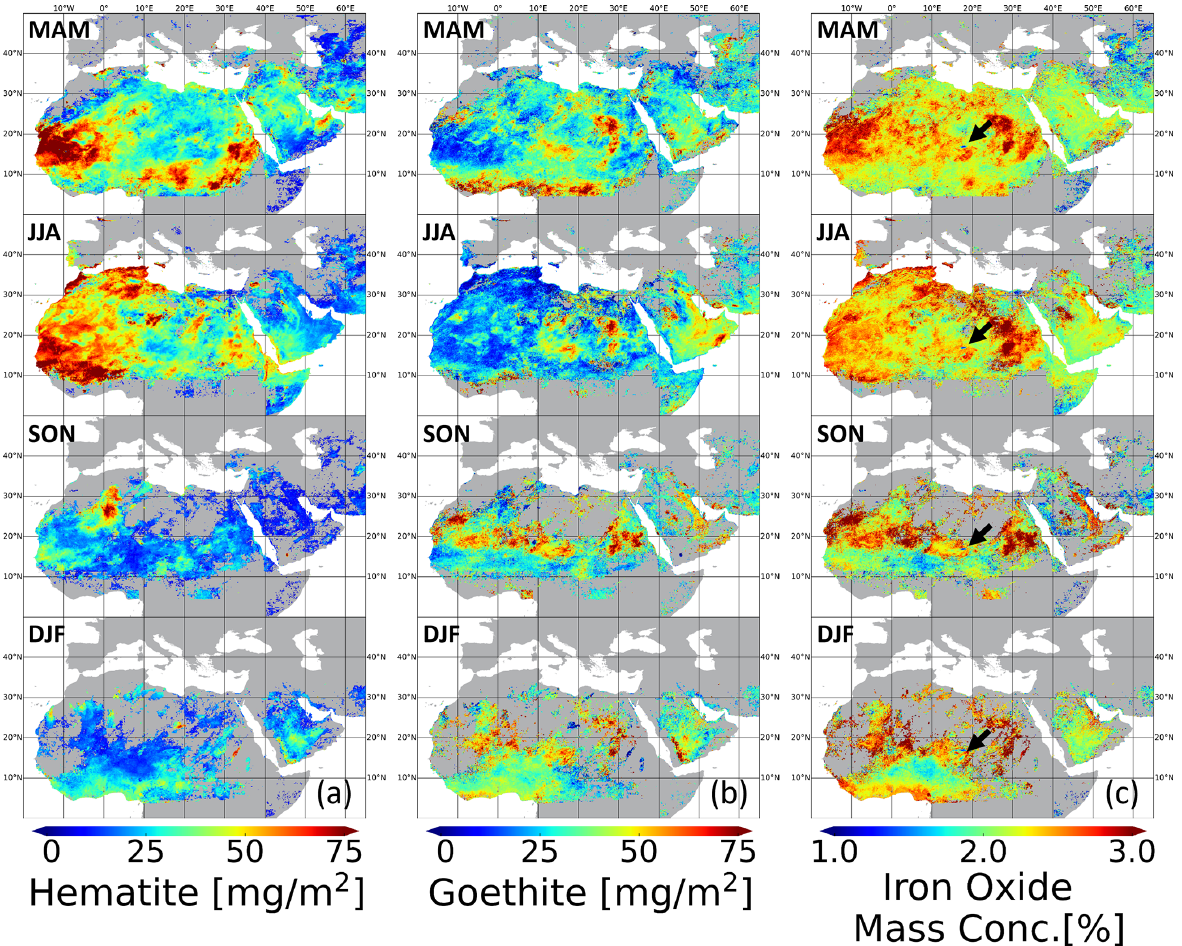
Figure 9. Seasonally average data for Sahara–Sahel and Middle East dust-source areas generated from MAIAC EPIC 2018 data (1 January to 31 December): (a) hematite mass concentration (mgm − 2 ), (b) goethite mass concentration (mgm − 2 ), and (c) iron-oxide mass concentration (wt%), with one row per season (row 1 – March, April, and May (MAM); row 2 – June, July, and August (JJA); row 3 – September, October, and November (SON); row 4 – December, January, and February (DJF)). Climatology data may include some mixed aerosol and smoke aerosol cases causing bias relative to pure-dust cases (Figs. 5, A1–A6). The four black arrows over (c) are pointing to the Bodélé Depression area. Additional data for AOD at 443nm and SSA at 443nm and the total number of data points used in this figure are provided in Fig. S2.